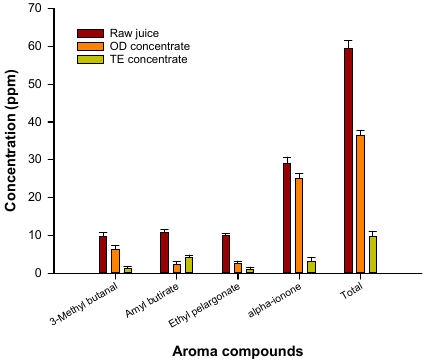
Figure 6. Aroma compounds in pomegranate juice and juice concentrated by osmotic distillation (OD) and thermal evaporation (adapted from [44]).